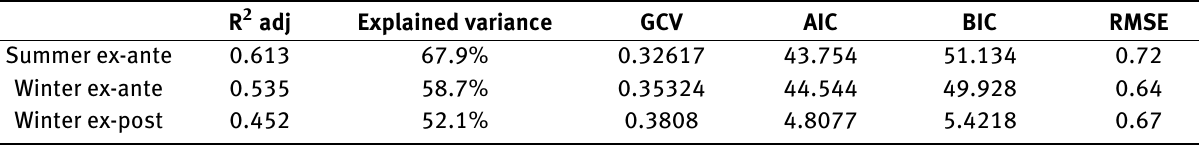
Table 6: Toluene, GAM models performance and summary statistics of leave one out cross-validation (LOOCV) R 2 adj Explained variance GCV AIC BIC RMSE